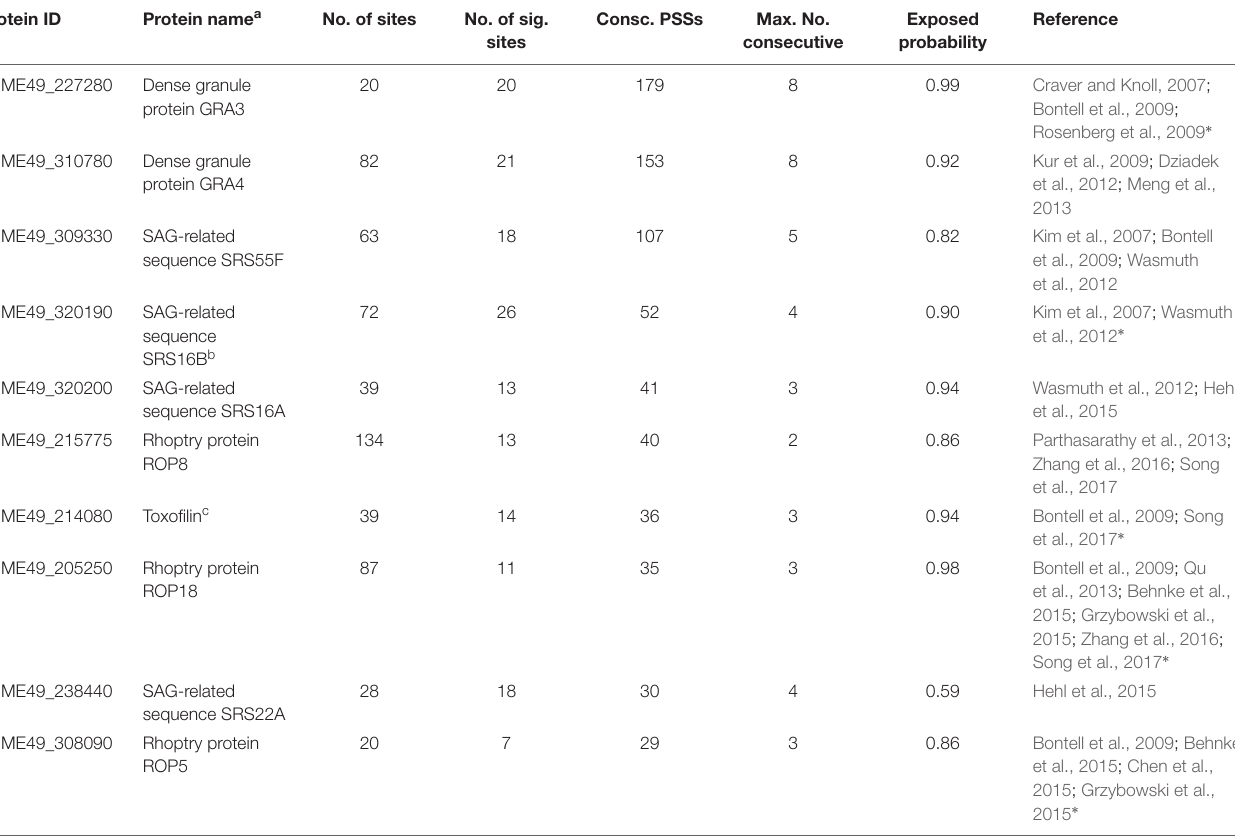
TABLE 5 | The top 10 predicted Toxoplasma gondii ME49 vaccine candidates for this study, i.e., proteins predicted to be exposed to the immune system, under positive selection, and contain consecutive positive selection sites on intermediate and/or high binding MHC I peptides. Protein ID Protein name a